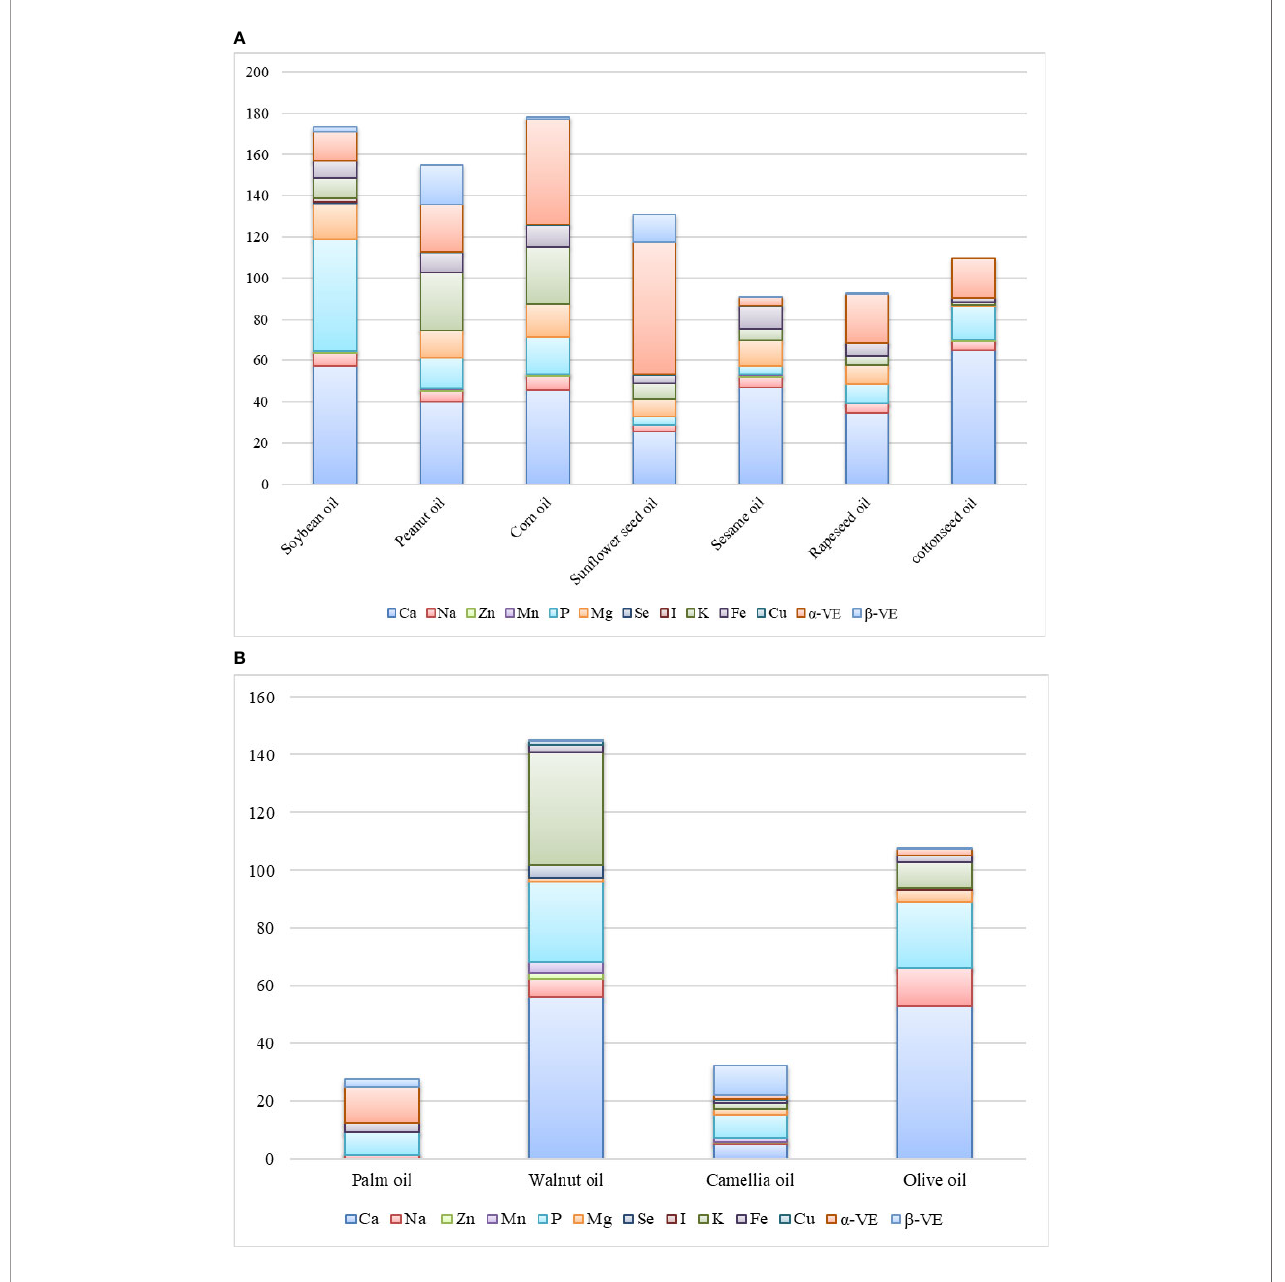
FIGURE 2 | Microactive compositions in (A) herbal edible plant oils (mg/100 g) and (B) woody edible plant oils